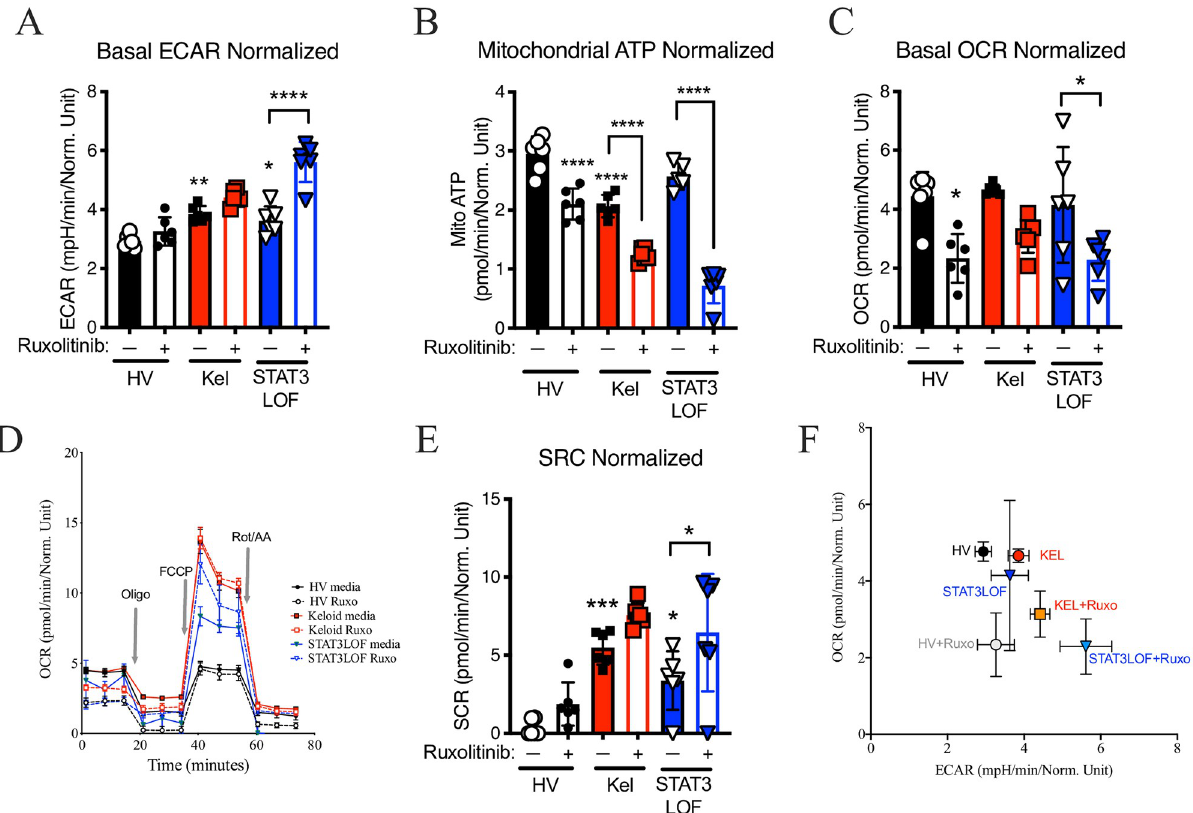
Fig 2. Abnormalities in metabolic balance were influenced by STAT3. Seahorse assay results for a healthy volunteer (HV) fibroblast line, a keloid (Kel) fibroblast line, or fibroblasts form patients with autosomal dominant hyper IgE syndrome due to STAT3 loss of function (STAT3LOF) with and without treatment with the JAK1/JAK2 inhibitor ruxolitinib (Ruxo): (A) basal extracellular acidification rate (ECAR), (B) mitochondrial ATP production, (C) basal oxygen consumption rate (OCR), (D) OCR tracing for indicated cell types during basal, oligomycin (Oligo) stimulation, carbonyl cyanide-4-(trifluoromethoxy)phenylhydrazone (FCCP) stimulated, and rotenone/antimycin A (Rot/AA) stimulation. (E) spare respiratory capacity (SRC), and (F) basal ECAR divided by basal OCR (ECAR/OCR ratio). Results are representative of three independent experiments and displayed as mean ± SEM for 5–6 wells per condition. � = p < 0.05; �� = p < 0.01; ��� = p < 0.001, ���� = p < 0.0001 versus HV with diluent condition unless otherwise indicated as determined by ANOVA with Sidak adjustment.